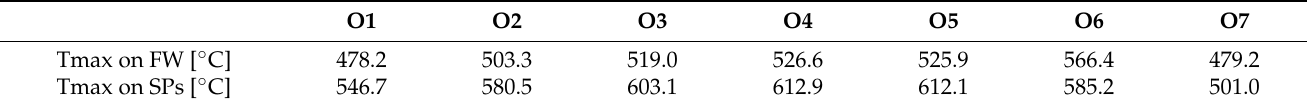
Table 3. Maximum temperature per region equipped with v06b